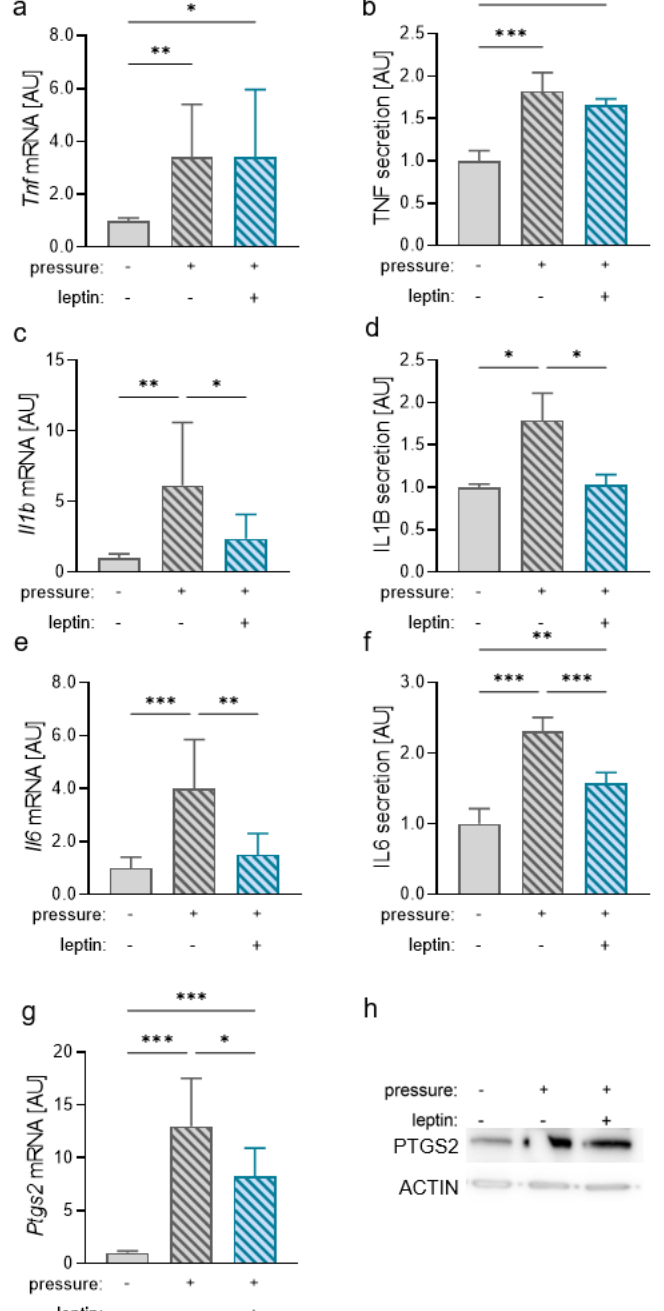
Figure 4. Impact of leptin in combination with compressive strain on TNF ( a , b ), IL1B ( c , d ), IL6 ( e , f ), and PTGS2 ( g , h ) gene and protein expression and secretion in RAW264.7 macrophages; n ≥ 4; Welch-corrected ANOVA with Dunnett’s T3 multiple comparisons test. * p < 0.05; ** p < 0.01; *** p < 0.001. Uncropped blot is presented in Figure S1.